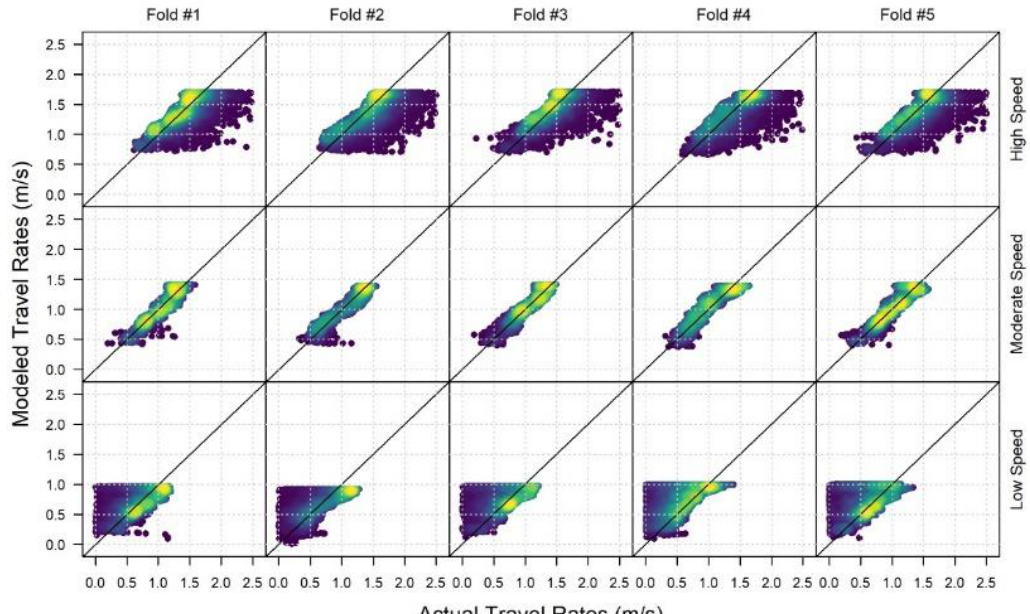
Figure 4. Actual versus modeled travel rates for the low, moderate, and high tertiles for each fold in k-fold cross validation. Density of points is shown on a blue-to-yellow color scale, where yellow represents the highest density.